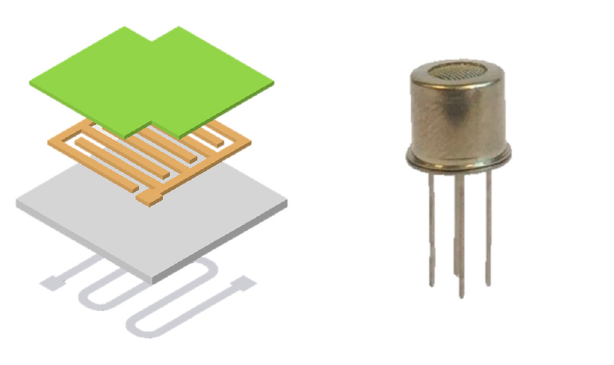
Figure 1. Sensor array top to down: sensing material, heater, alumina substrate, heater ( left ) and sensor in a TO5 fitting ( right